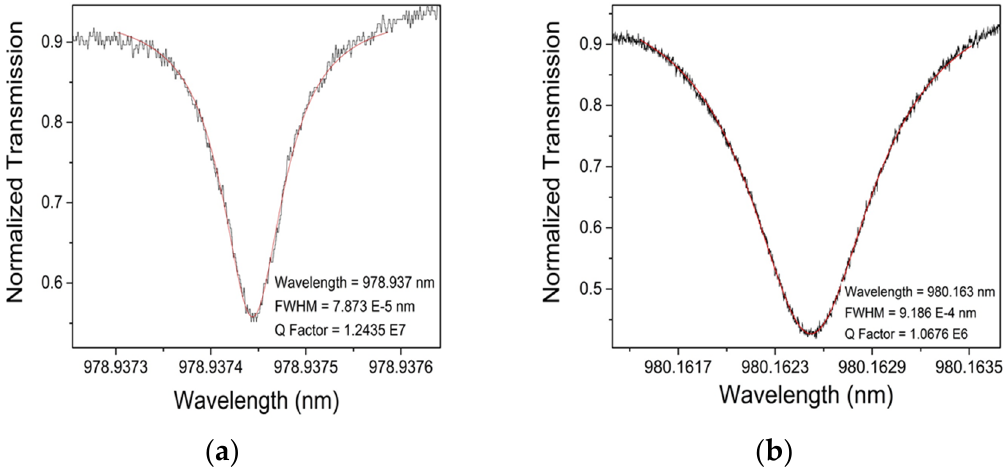
Figure 11. Q Factor graphs taken from a coated sphere before and after the extraction process. ( a ) depicts the fundamental peak of a coated sphere with a Lorentzian fit curve; the Q factor obtained was 1.243 × 10 6 ; ( b ) depicts a similar peak on the same sphere following extraction via O 2 plasma; its Q factor was 1.006 × 10 6 . Please note that the values given on the graph represent the direct output of the fitting and do not take into account the precision of the equipment. Transmission data (mW) were normalized based on the initial transmission of the laser.